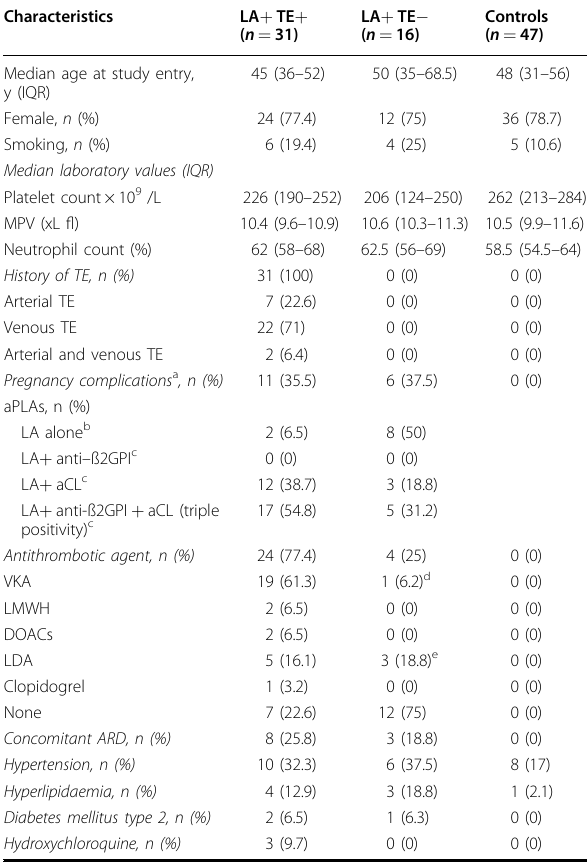
Table 1 Baseline demographic, clinical and laboratory data of the study